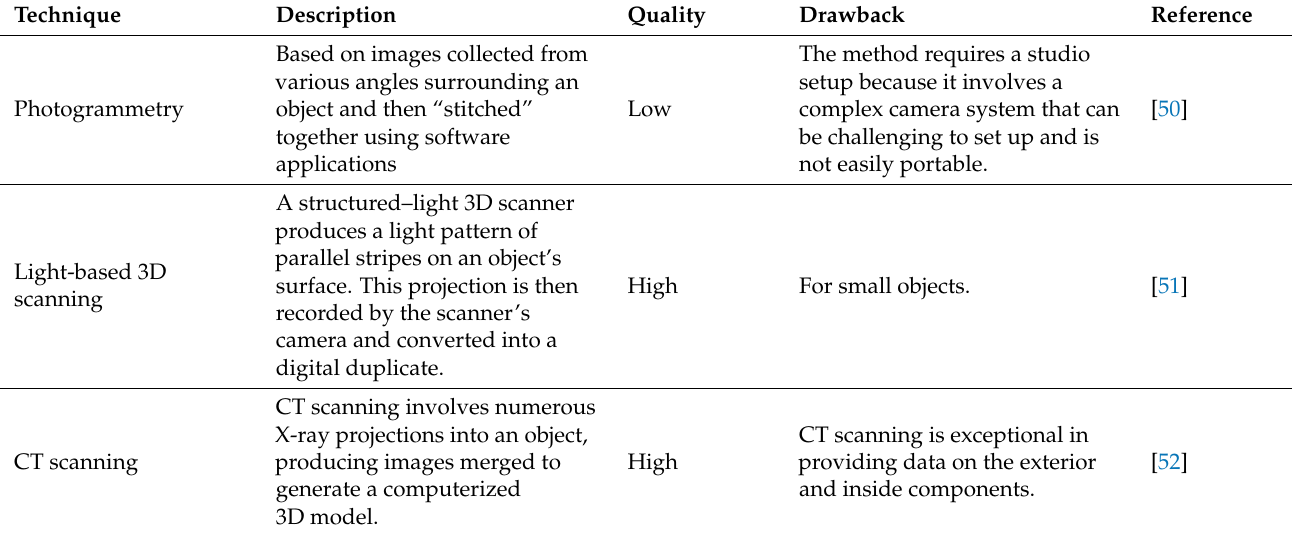
Table 2. Data acquisition